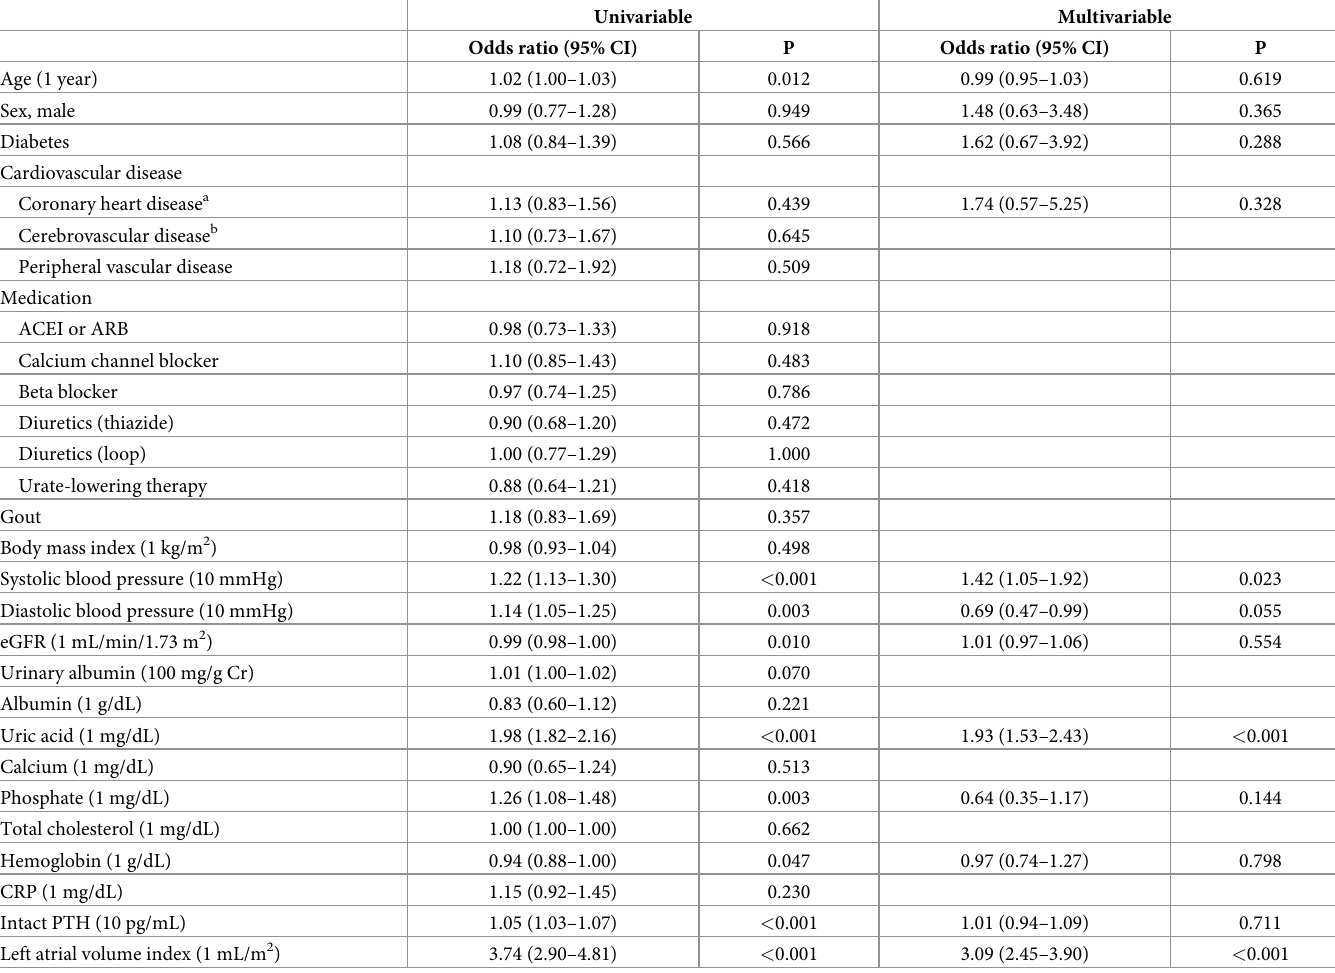
Table 5. Univariable and multivariable analyses for variables associated with LVDD in study population (n = 1025).